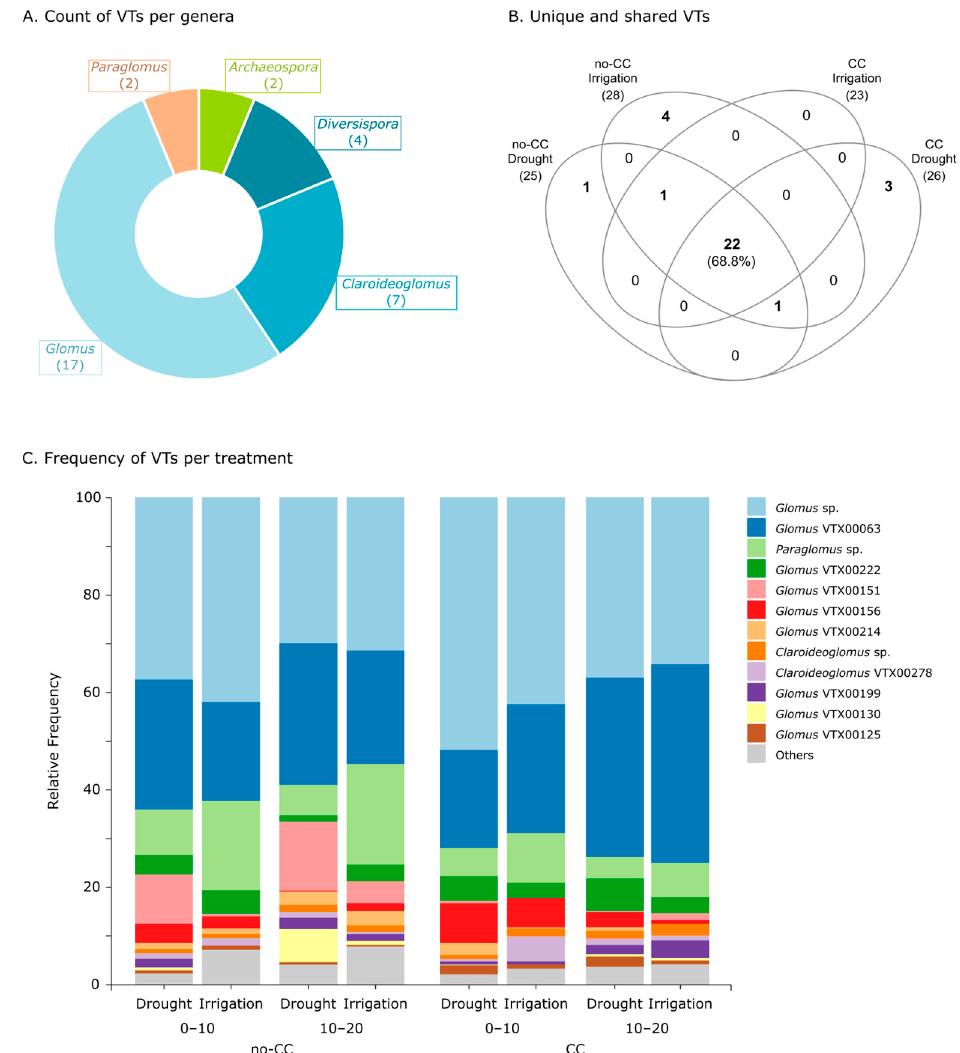
Figure 4. Pie chart showing the number of arbuscular mycorrhizal fungi (AMF) virtual taxa (VTs) per genus ( A ); Venn diagram showing unique and shared AMF VTs between treatments ( B ); and taxa bar plots showing the relative frequency of AMF VTs in each treatment ( C ). In ( B , C ), data are shown for both cover crop (no-CC: no cover crop; CC: 4-species cover crop) and water supply (drought; irrigation) treatments. In ( C ), data is also shown by soil depth (0–10 and 10–20 cm), and only the highest abundance VTs are shown, while the rest are collapsed into the “Others” category. Taxa bar plots at the genus level, both pooled and by individual field replicate, can be found in Figure S6.